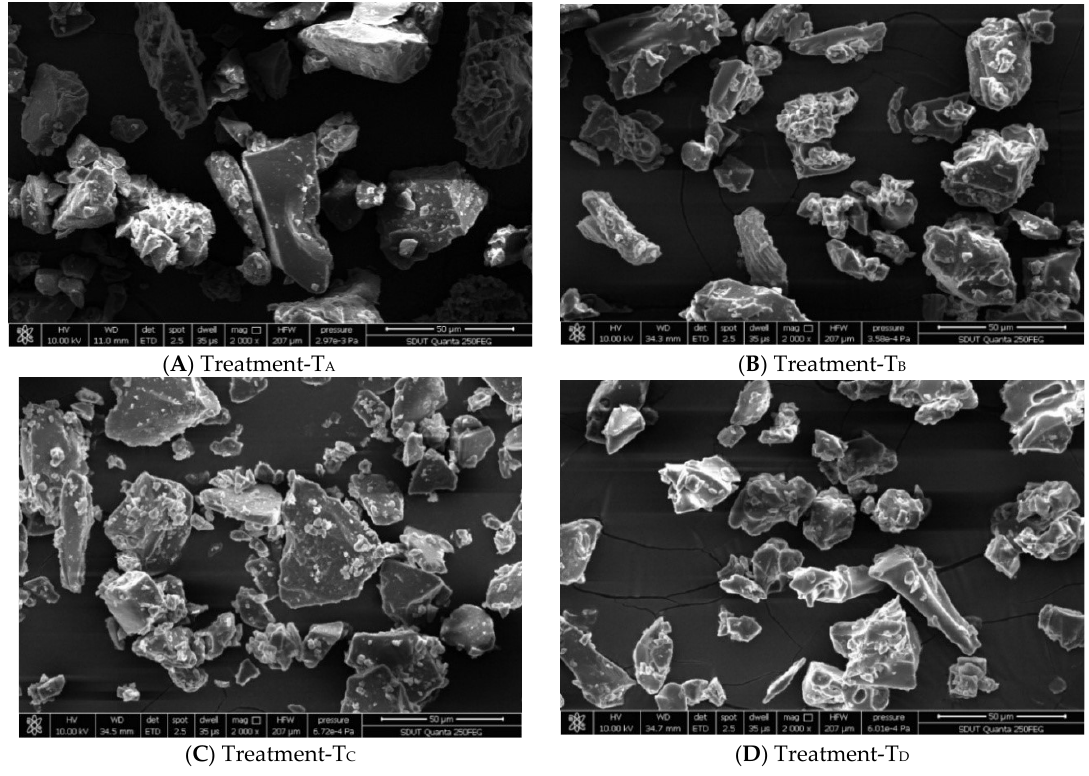
Figure 3. ( A – D ) Micrographs of PHF extract microencapsulated with GA, GE, MD and their combinations by freeze-drying method. ( A ) Treatment-T A : Freeze-dried, with 5% GA & 5% GE; ( B ) Treatment-T B : Freeze-dried, with 5% GA & 5% MD; ( C ) Treatment-T C : Freeze-dried, with 10% GA; ( D ) Treatment-T D : Freeze-dried, with 10% MD.